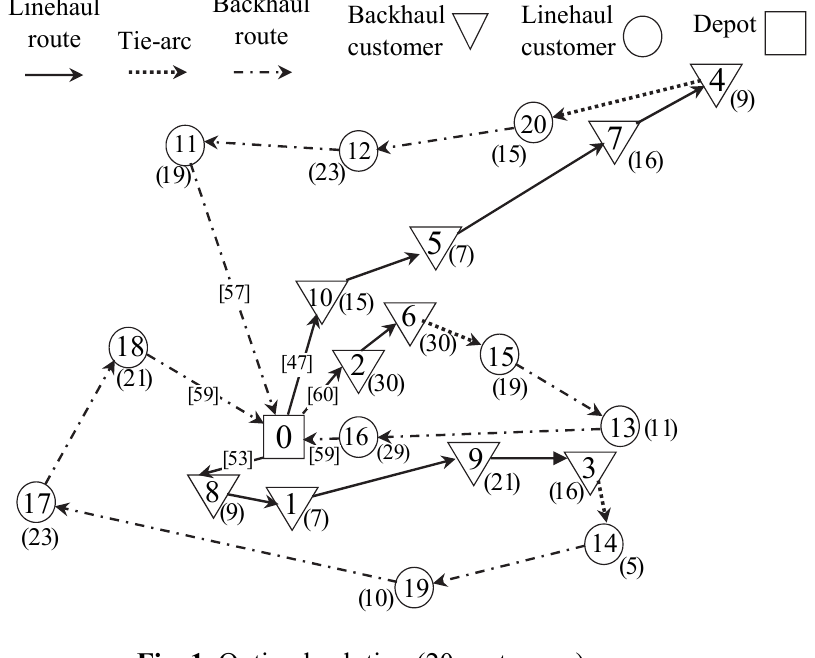
Fig. 1. Optimal solution (20